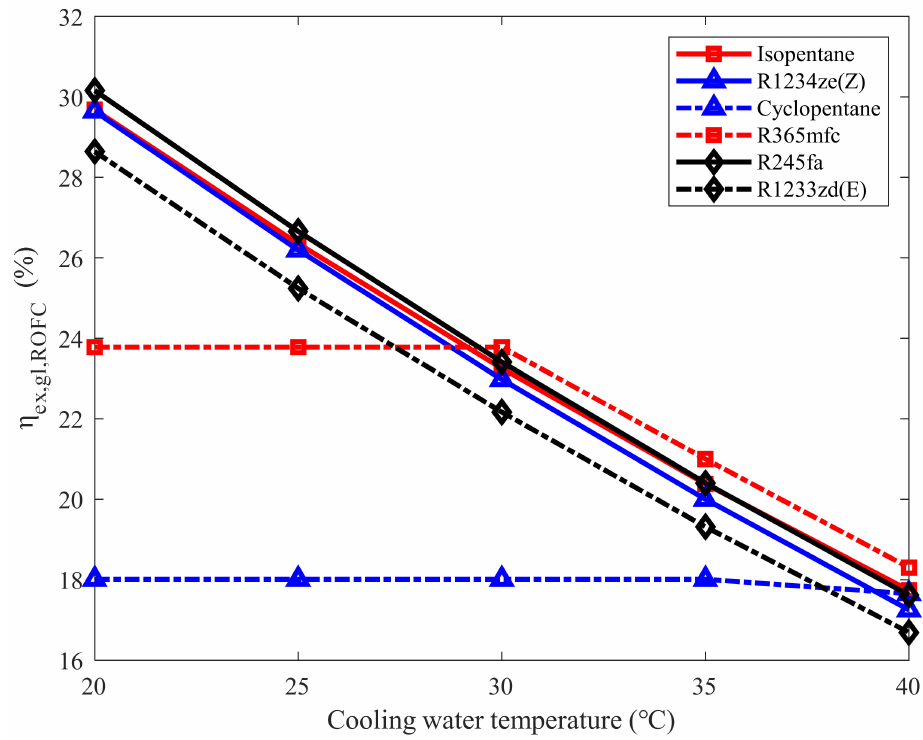
Figure 13. Effect of the cooling water temperature on the global exergy